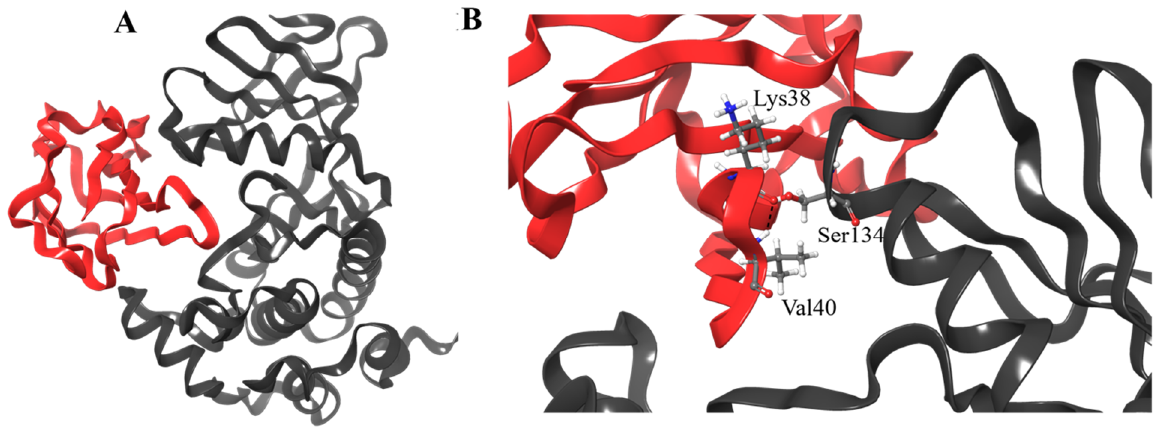
Figure 3. ( A ) Structural representation of MARK4 enzyme (ribbon view—black color) in complex with irisin (ribbon view—red color). ( B ) Close view of interactions formed between the carbon backbone atoms of MARK4 and irisin.